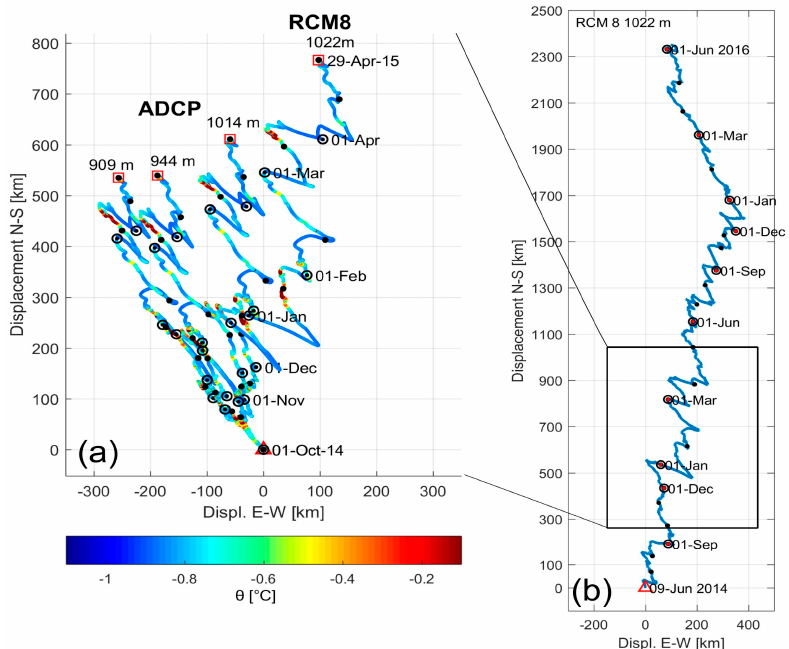
Figure 8. Progressive vector diagram of sub-tidal flow at S1. Panel ( a ): data from ADCP at different depths (909 m, 944 m, and 1014 m) and from current meter RCM8 at 1022 m within the period 1 October 2014–30 April 2015. The colorbar refers to θ at 1017 m depth. Panel ( b ): data from RCM8 at 1022 m within the whole 2-year period (June 2014–June 2016). Black dots correspond to the beginning of each month.